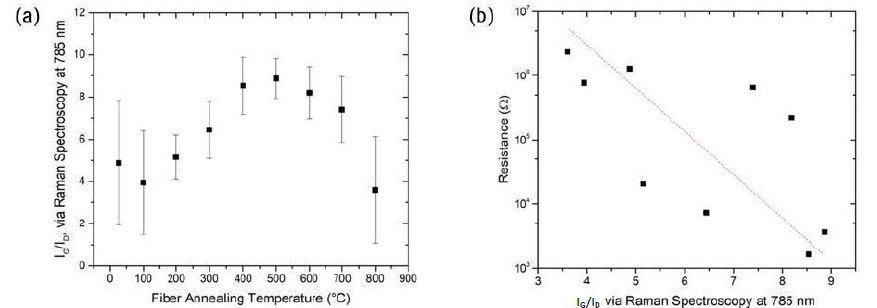
Figure 7. ( a ) Relative intensity of the G- and D-peaks in the resonant Raman spectra for CNT fibers at 785 nm as a function of annealing temperature in the nanoprobe and ( b ) electrical resistance of the CNT fibers as a function of the relative intensity of the G- and D-peaks. There is a general inverse relation of electrical resistance with I G /I D .